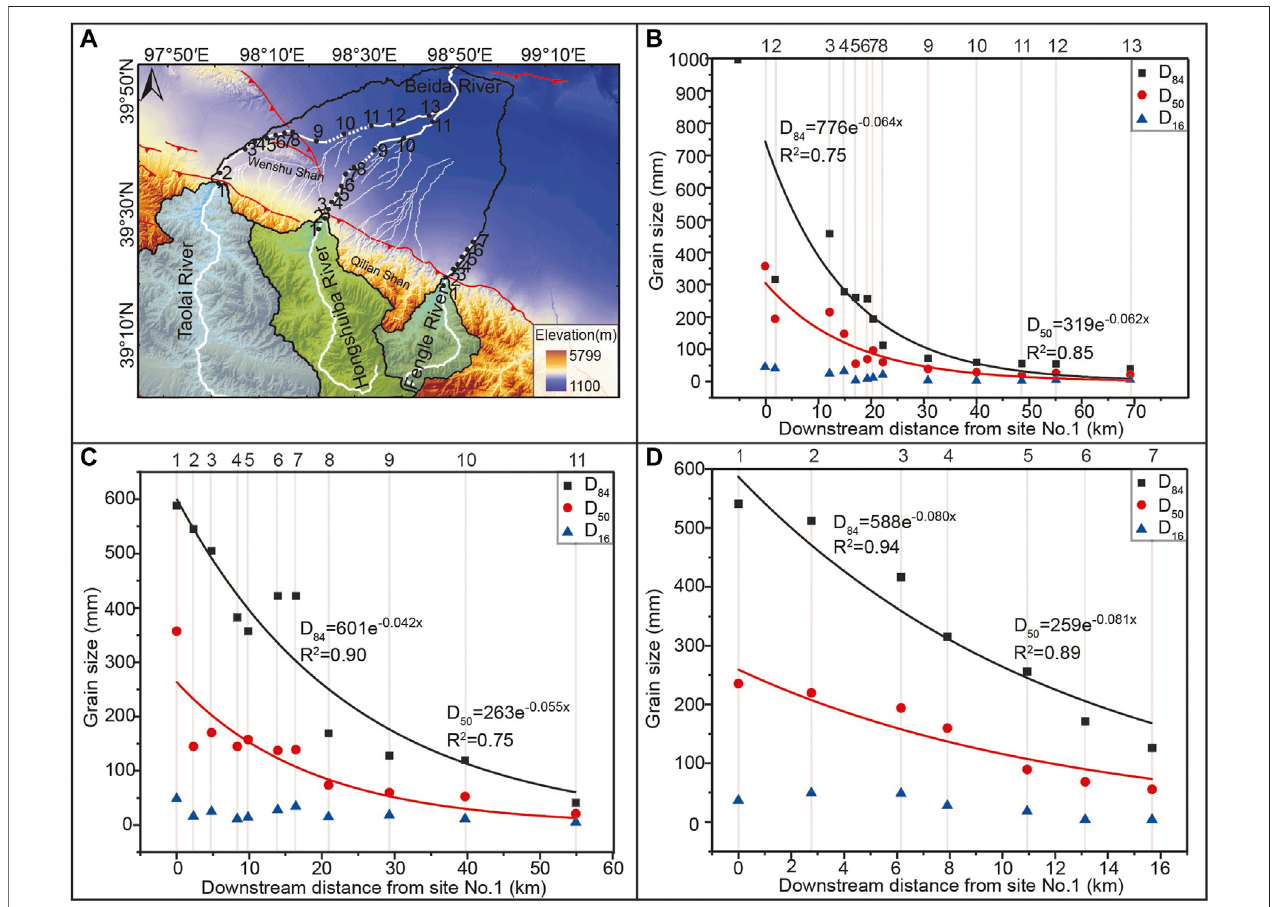
FIGURE 5 | Variation pattern of D 84 , D 50 , and D 16 toward downstream. (A) The Beida River catchment. (B) , (C) and (D) Downstream variation in the three indexes along the Taolai, Hongshuiba, and Fengle Rivers, respectively. Their variations all follow an exponential fi tting pattern, in which the fi tting correlation coef fi cients for D 84 and D 50 can reach up to > 0.75. All the sampling sites are marked by number sequence which is coincident with (A) .